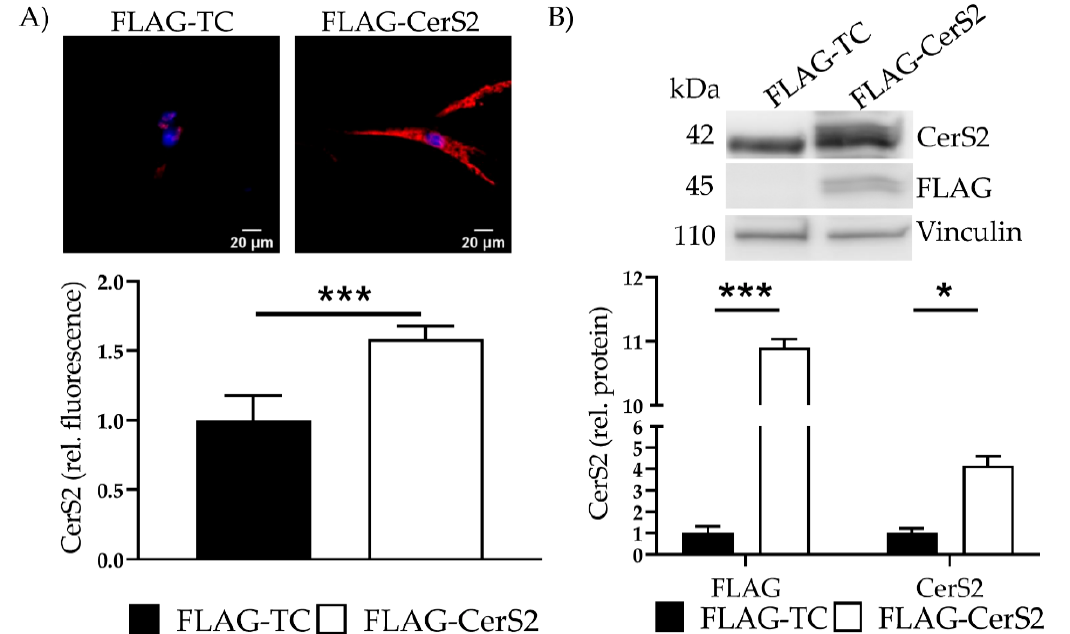
Figure 7. FLAG-CerS2—CerS2 protein expression and ceramide levels. ( A ) CerS2 was stained (red). Nucleus was stained blue. Intensity was determined with cLSM. Illustrated are two representative pictures. ( B ) Marker protein FLAG and CerS2 expression were assessed with WB. Shown is one representative blot. Depicted are mean values and standard deviation of minimum three biological replicates. Significances were calculated with a t -test. * = significant to FLAG-TC (* p ≤ 0.05, *** p ≤ 0.001).